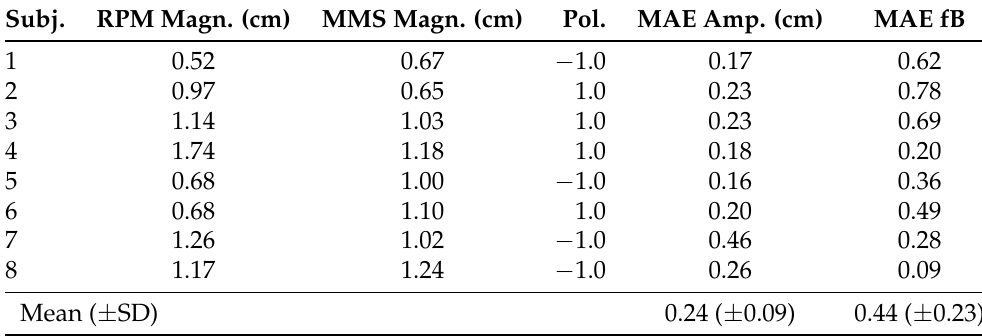
Table 3. Mean signal magnitudes for RPM and MMS respiration signals, the polarity of the respiration signal ( q ), the mean absolute error of the MMS signal with respect to RPM signal and the mean absolute breathing error rate per minute for the MMS signal with respect to RPM for the considered 8 subjects. Subj.